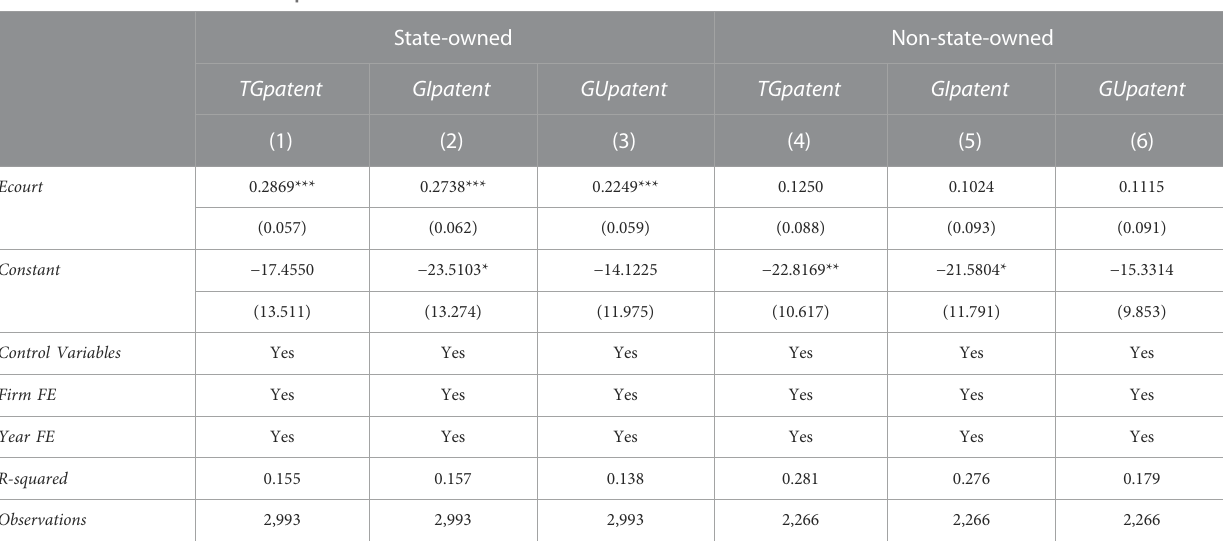
TABLE 9 Differences in fi rms ’